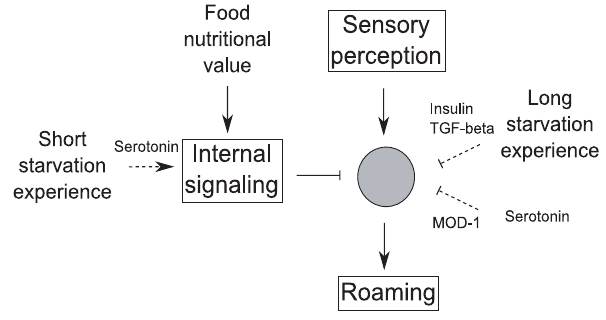
Figure 5. Proposed schematic representation of the control of the dwelling and roaming behavior by sensory perception and internal signaling.